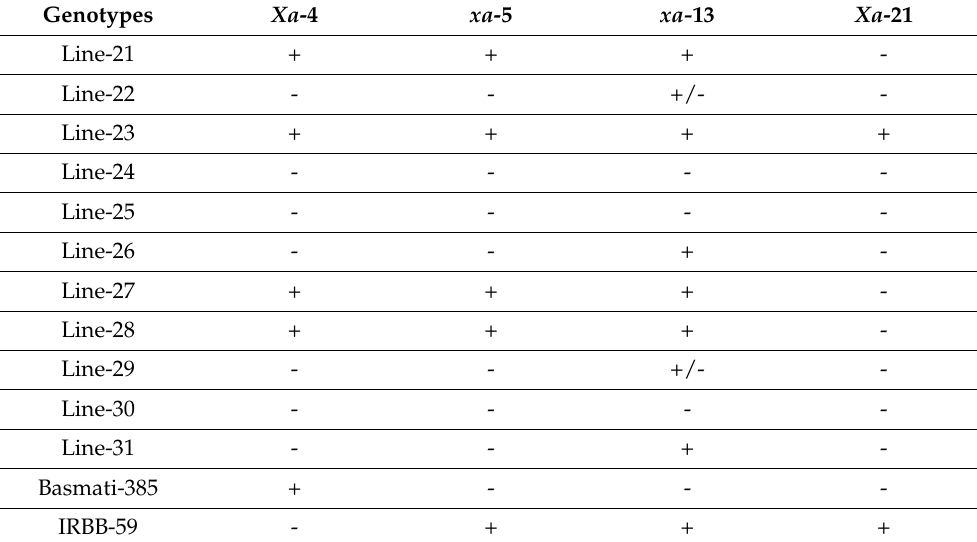
“+” for presence and “-” for absence of Xa genes.